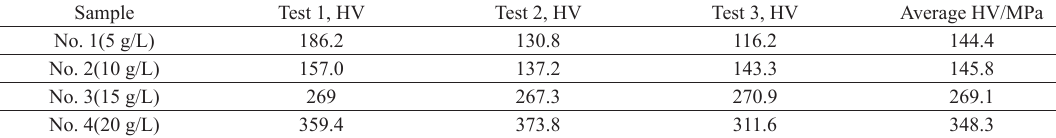
WO concentrations. 2 4